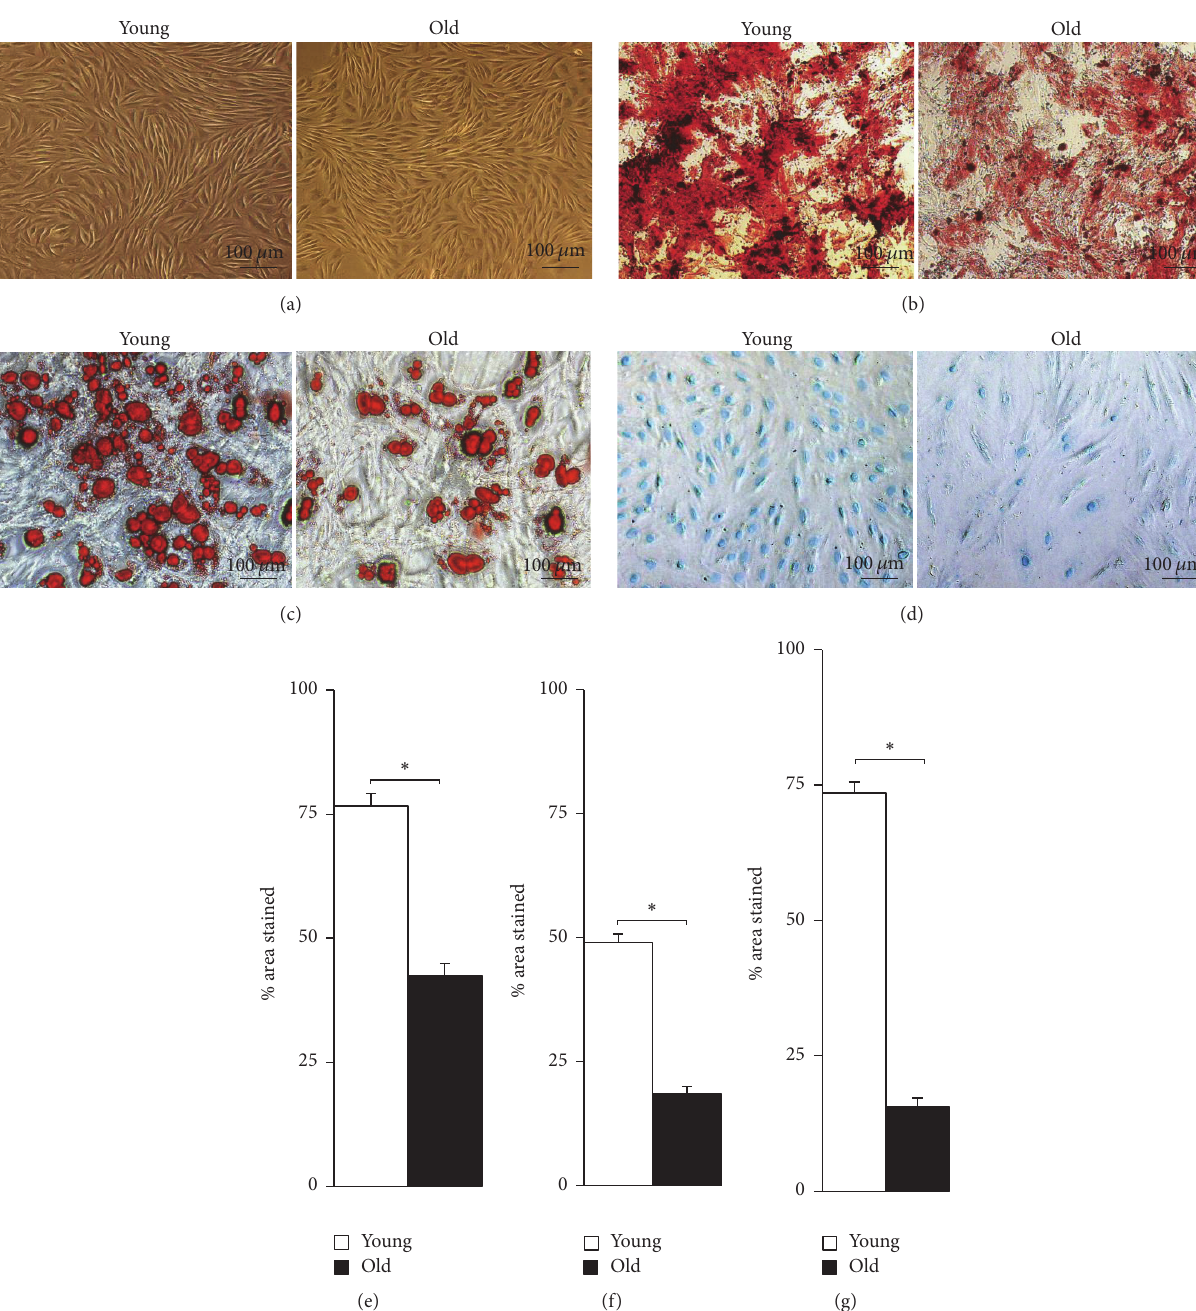
Figure 5: Multipotent differentiation capacities of NPMSCs ( 𝑛 = 5 ). (a) Young and old NPMSCs at P3 served as controls. (b) Osteogenic differentiation of young and old NPMSCs stained with Alizarin Red after 21 days of induction. (c) Adipogenic differentiation of young and NPMSCs stained with Oil Red O after 28 days of induction. (d) Chondrogenic differentiation of young and old NPMSCs stained with Alcian Blue after 21 days of induction. (e) Percentage of total area that was positively stained with Alizarin Red. (f) Percentage of total area that was positively stained with Oil Red O. (g) Percentage of total area that was stained with Alcian Blue. The data are expressed as means ± SD. ∗ indicates 𝑃 < 0.05 . A complete decrease in osteogenic, adipogenic, and chondrogenic differentiation capacities was observed in NPMSCs due to increasing donor